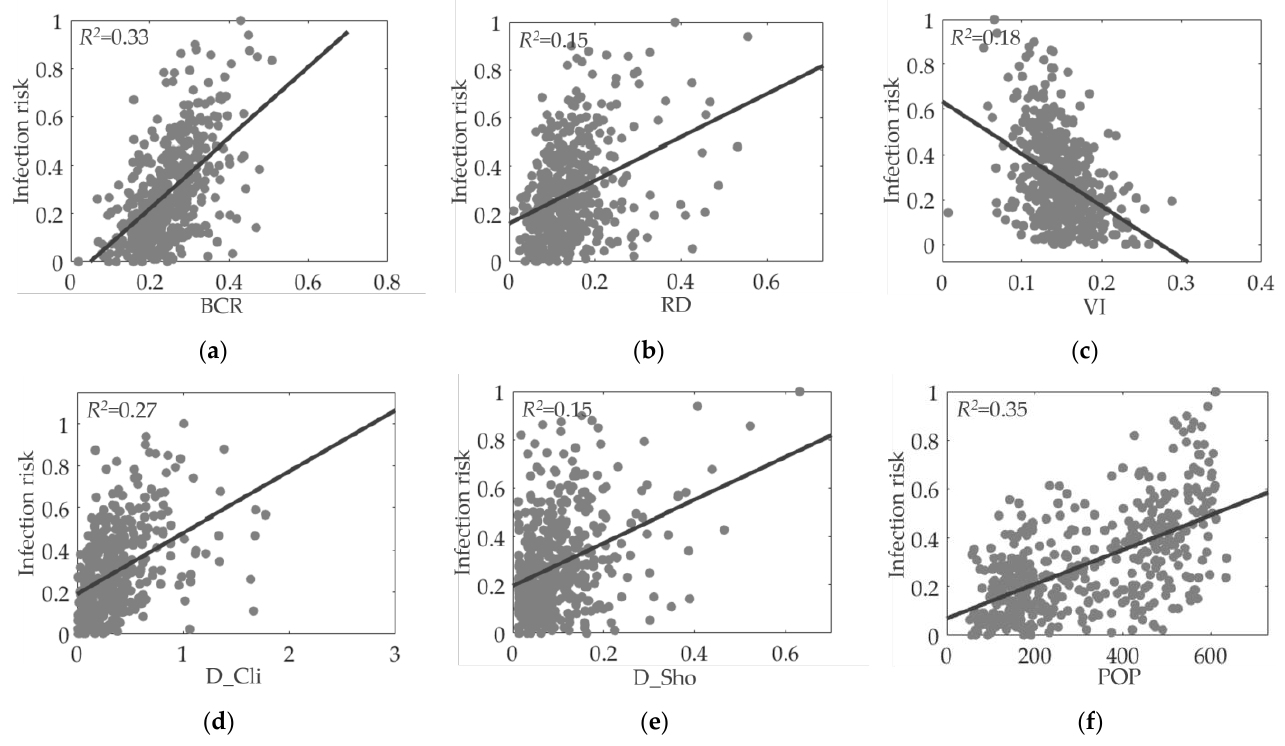
Figure 8. Impact of urban environment features on COVID-19 infection rate in Shanghai: ( a ) Building coverage ratio; ( b ) Road density; ( c ) Vegetation index; ( d ) Density of clinics; ( e ) Density of shops; ( f ) Population.